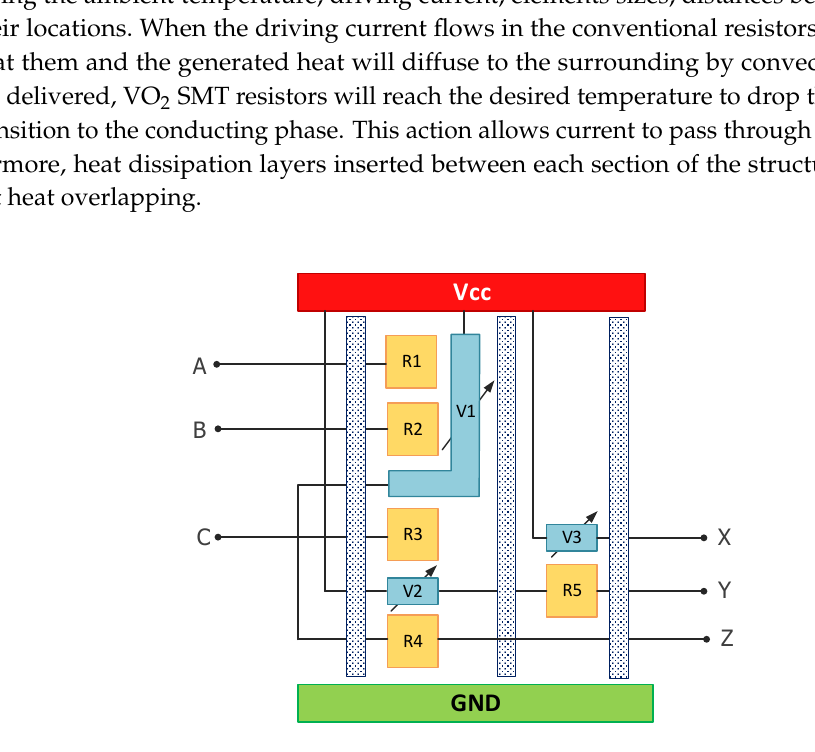
Figure 2. Implementation of VO 2 thermal switching in a TELC